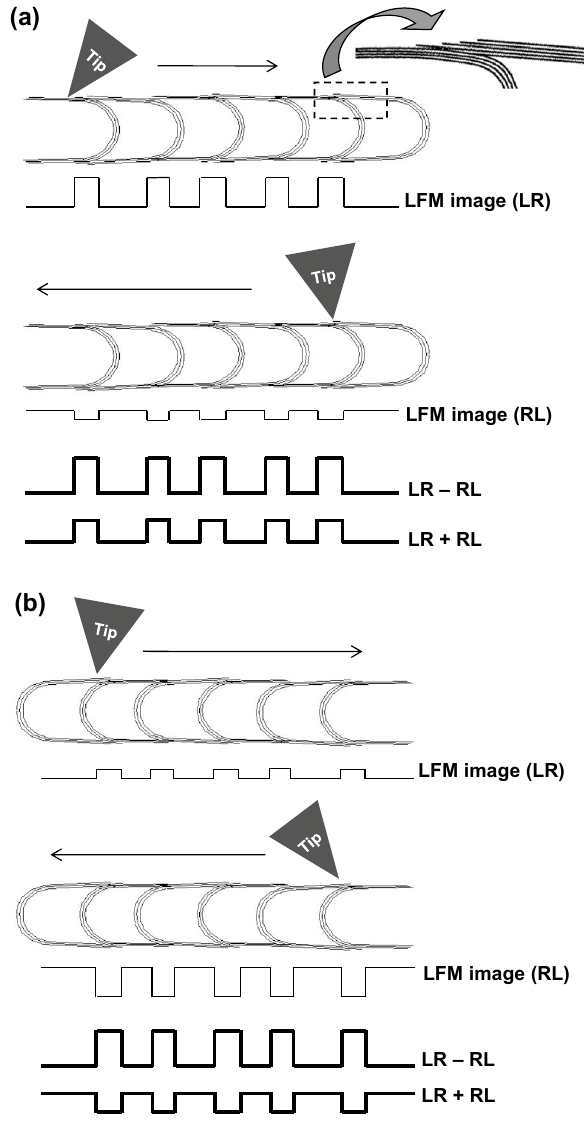
Figure 3. A schematic illustrating the principles of lateral force microscopy (LFM) imaging carried out by scanning along the axial direction of the bamboo-shaped multi-walled carbon nanotube (BS-MWCNT) when the protruding direction of the compartmented structure is ( a ) to the right and ( b ) to the left. LR, left-to-right; RL, right-to-left. LR − RL and LR + RL are the resulting images by subtracting and adding the LFM images,